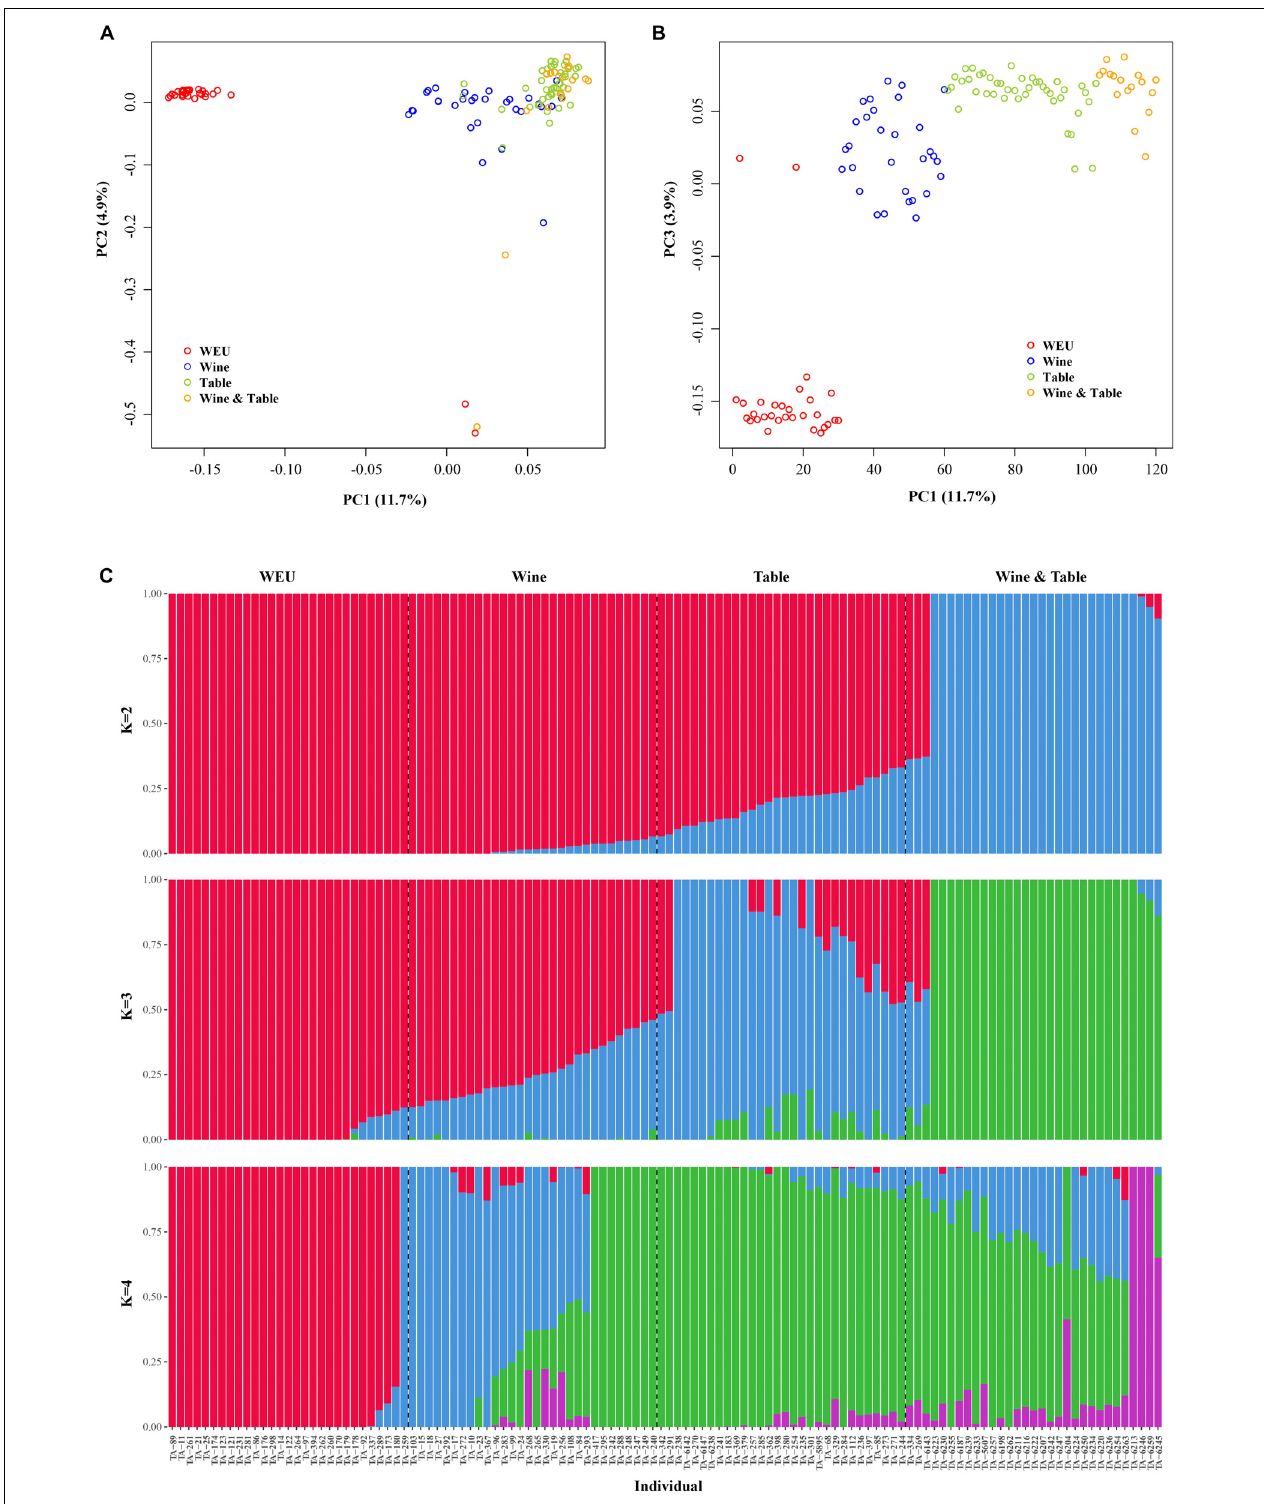
FIGURE 1 | Population structure analyses of all accessions. (A,B) PCA analysis of all accessions in this study. (C) Population admixture of all Vitis accessions. Each color represents one ancestral population. Each accession is represented by a vertical bar, and the length of each colored segment in each vertical bar represents the proportion contributed by ancestral populations. WNA, Wine, and Table represent wild European grapevine, wine grape accessions, and table grape accessions, respectively.